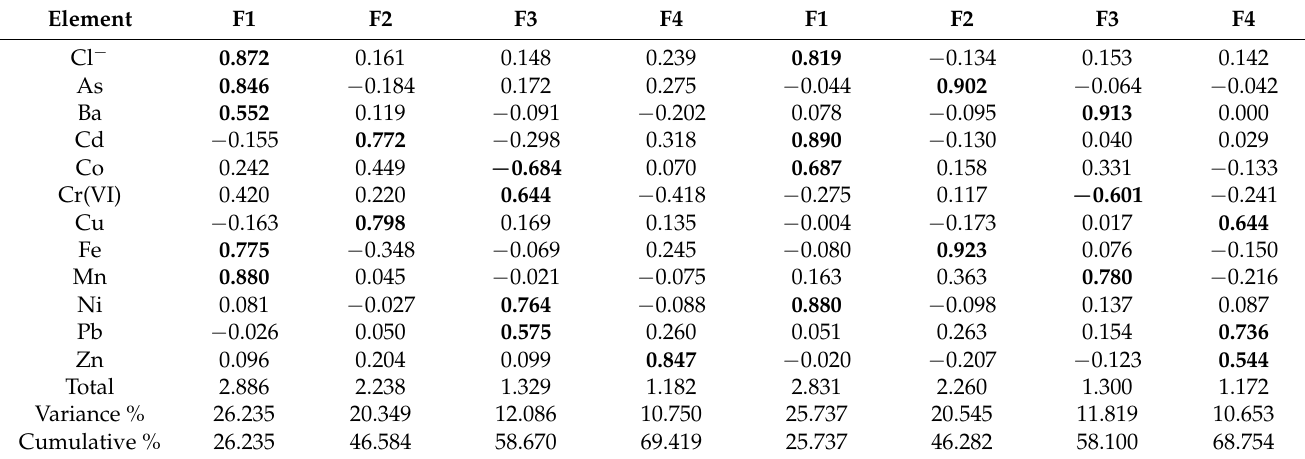
Table 3. Common factors and total variance contribution rate of pollutants.